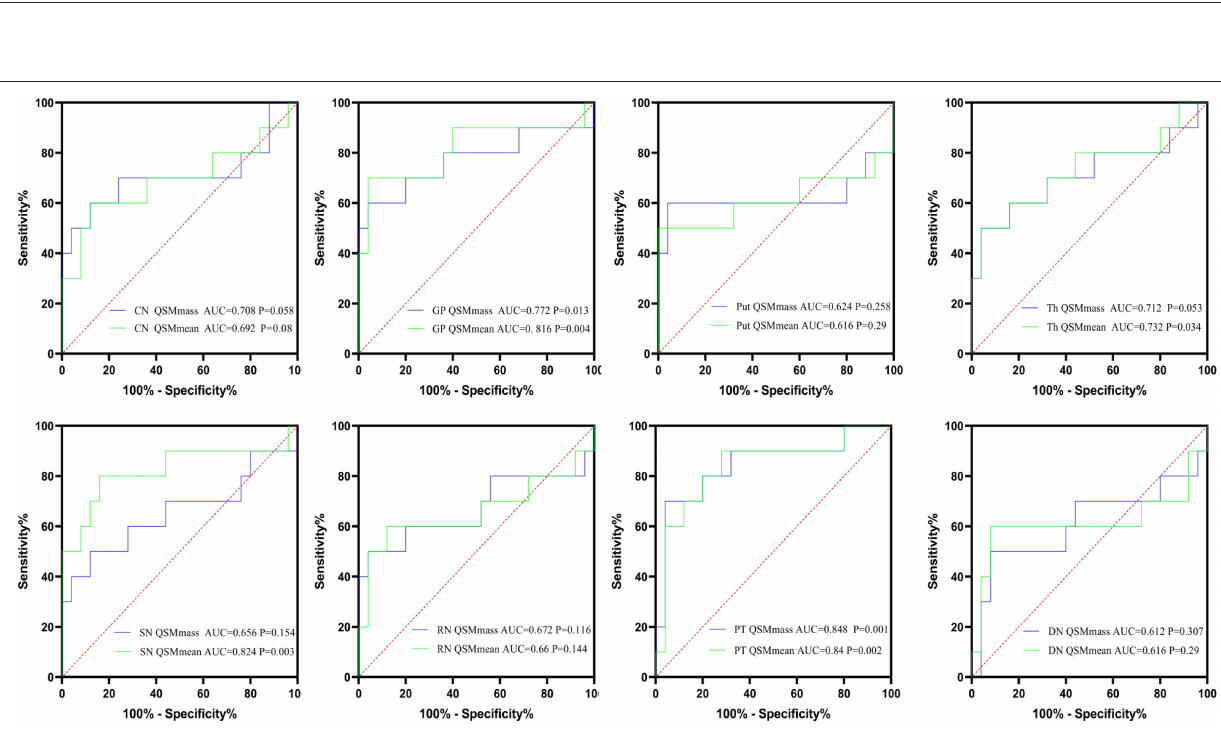
Frontiers in Neuroscience |